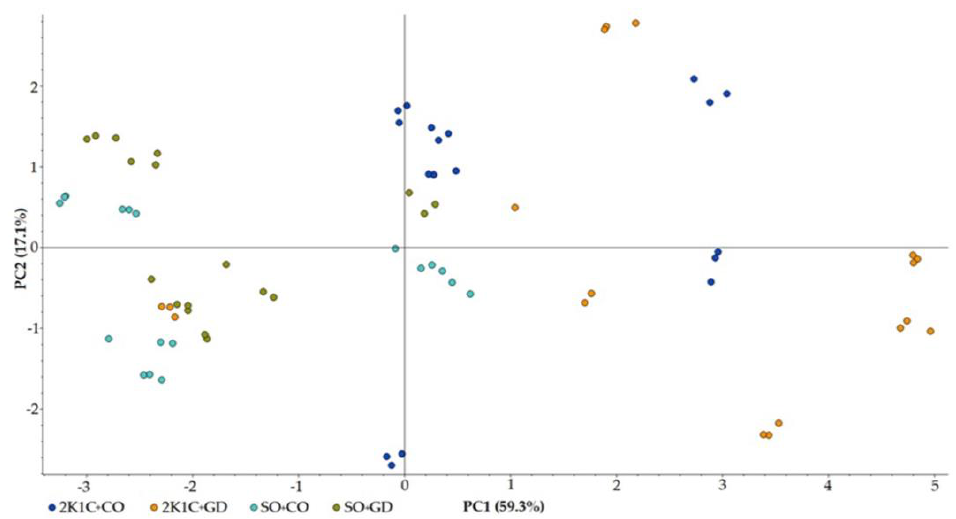
Figure 10. Scores plot of the principal-component analysis (PCA) showing correlations between the rat groups. Injections were conducted in triplicate per rat ( n = 6 rats per group).